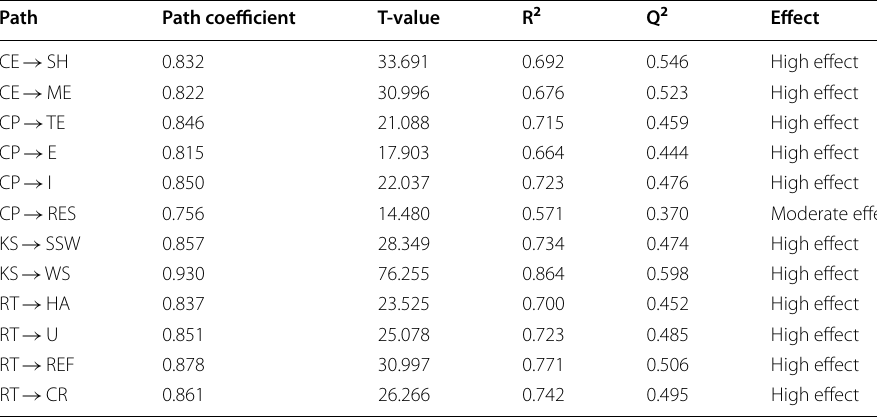
Table 5 Evaluation of hierarchical model result